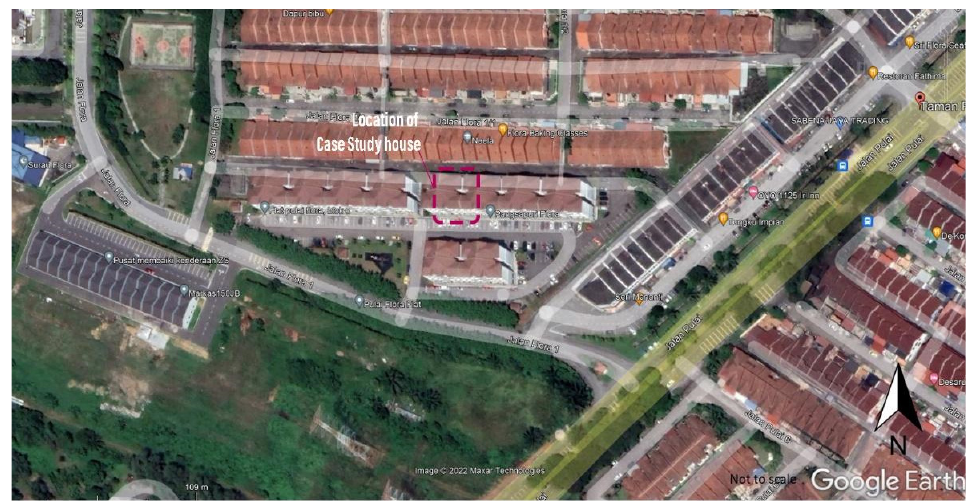
Figure 1. Location plan of the case study building, as seen from Google Earth. Table 1. Case study building.